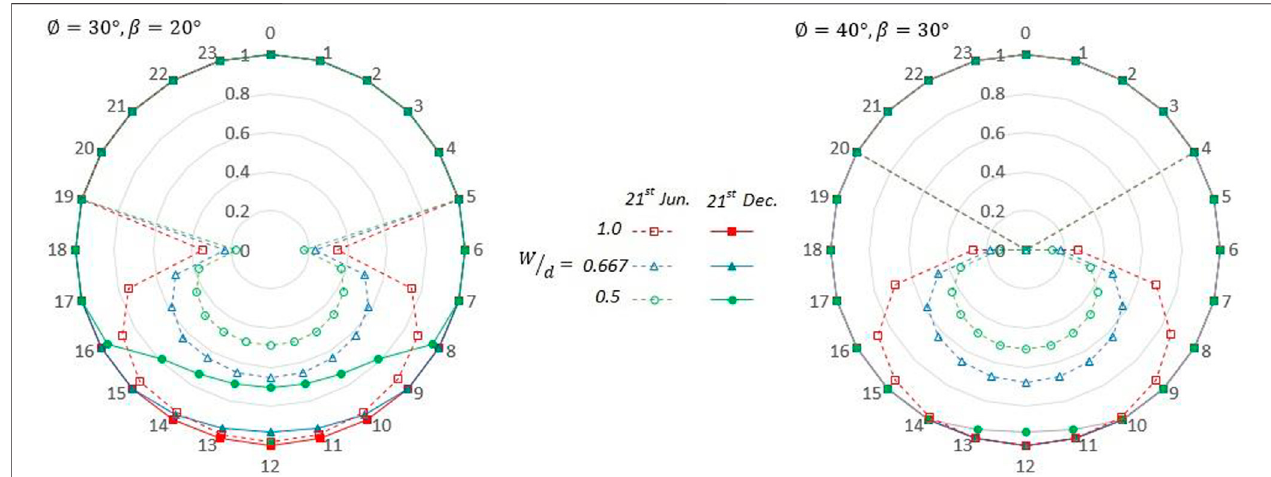
FIGURE12| Comparisonoftheshadowzonelengthratio Z 1 ratio W is a d